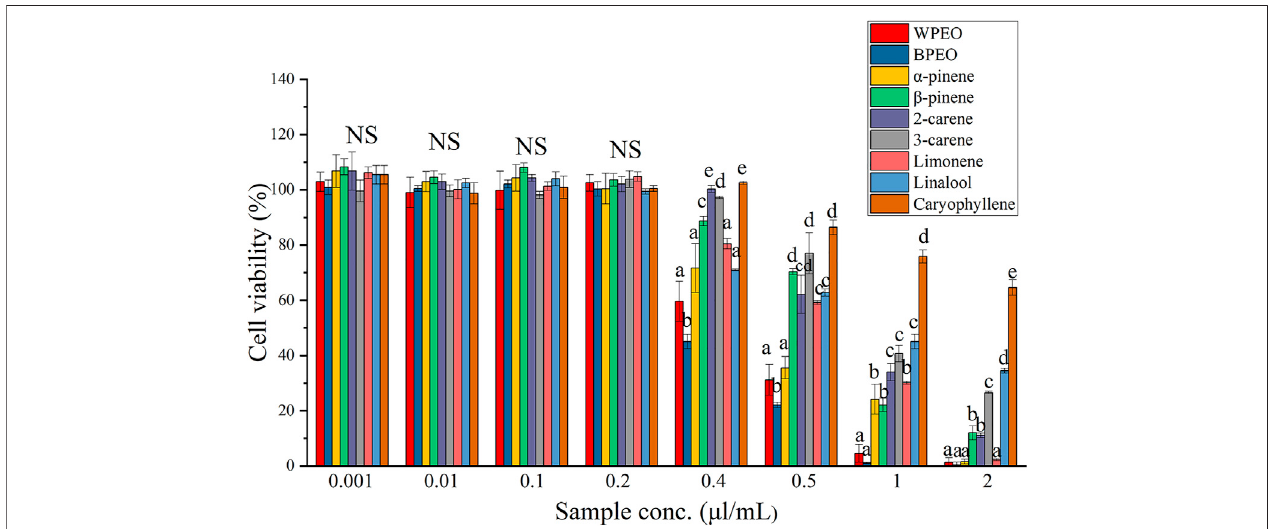
FIGURE1| Effects ofWPEO, BPEO,and sevenstandards oncell viabilityin HeLacells. (Dataare reportedasthe mean ± SDofthree replicates. Barswithdifferent letters are signi fi cantly different at p ≤ 0.05 according to one-way ANOVA; NS, not signi fi cant difference; WPEO, white pepper essential oil; BPEO, black pepper essential oil).